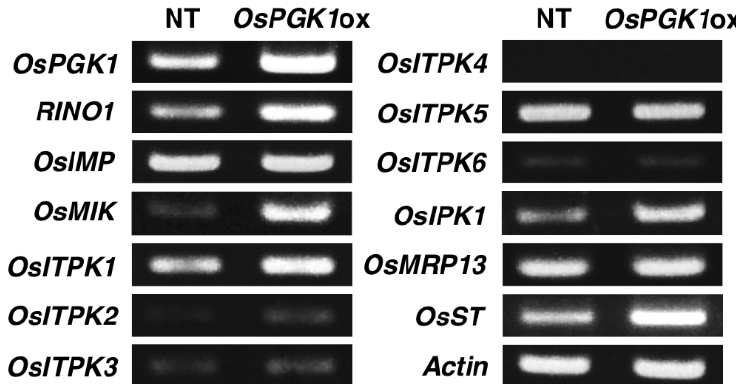
Figure 6. Semi-quantitative RT-PCR analysis of the expression of 13 phytic acid biosynthesis-related genes in the OsPGK1ox and NT plants. Total RNA was extracted from the roots of non-transformant (NT) and OsPGK1ox-1 3 d after germination. Actin was used as a